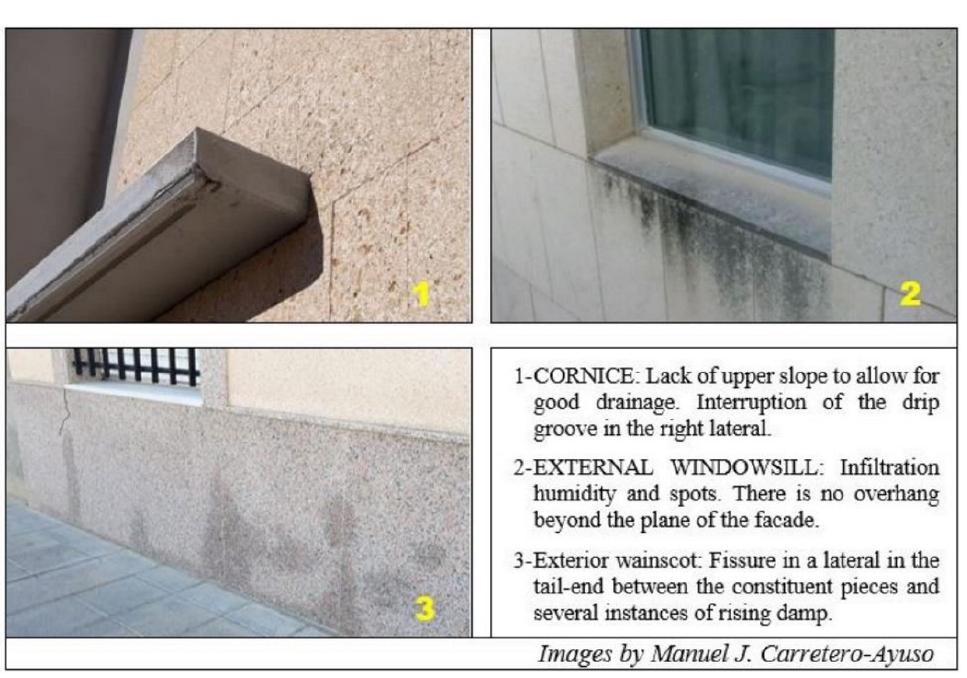
Figure 1. Photographic examples of defects in the three types of elements.